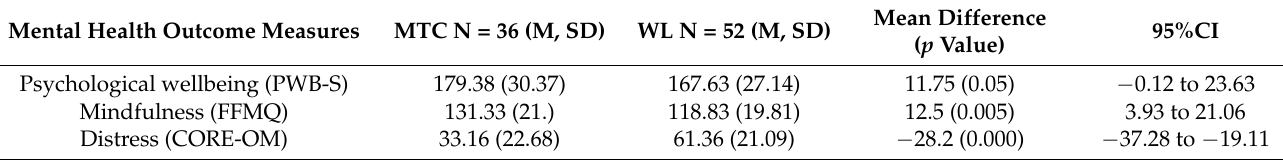
Table 6. Comparison of mental health outcome measures at post intervention.